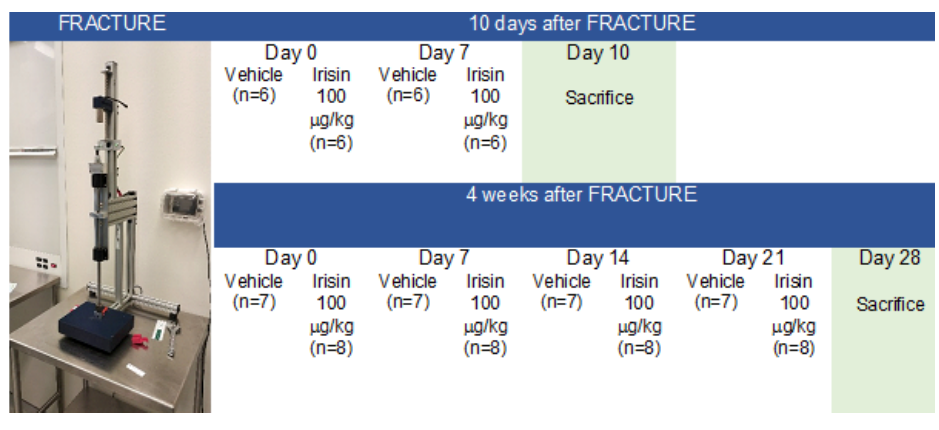
Figure 5. Experimental plan.